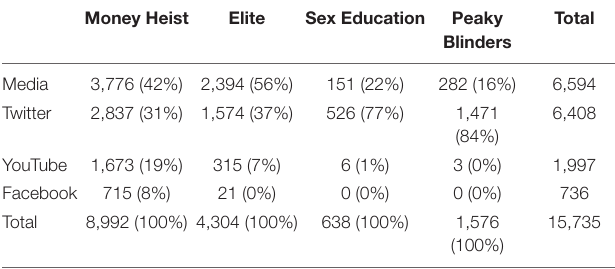
TABLE 1 | Sources, frequencies, and percentages.